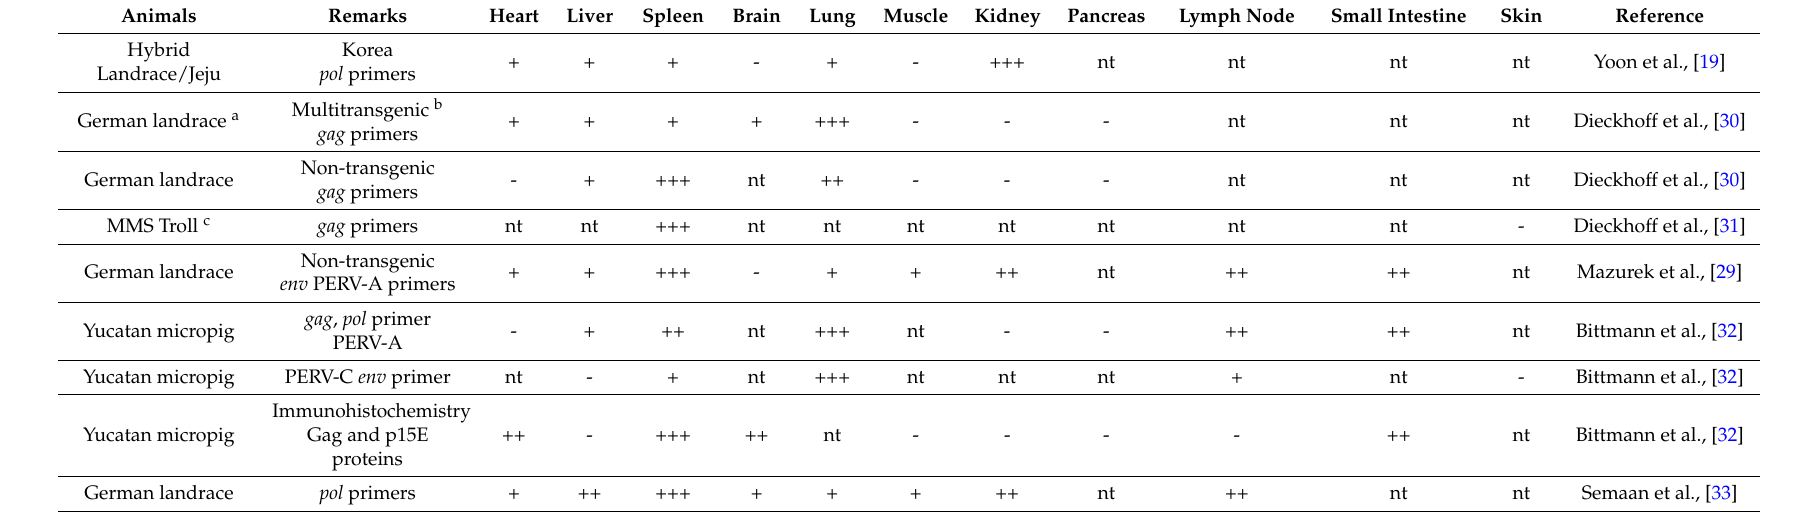
Table 2. PERV expression in different tissues of different pig